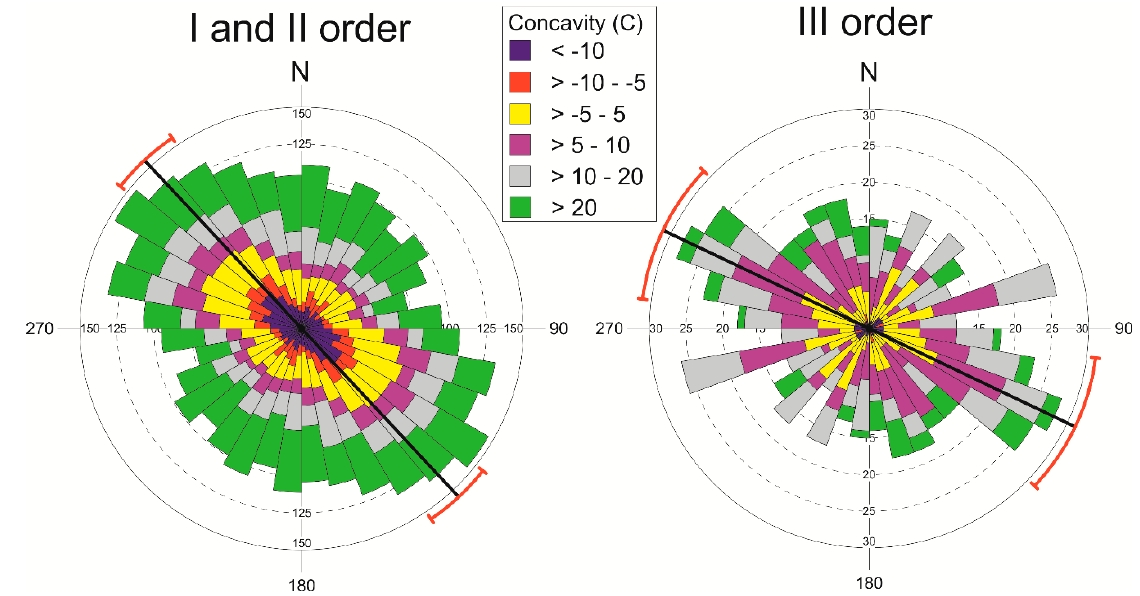
Figure 10. Length-weighted rose diagrams computed for different values of the concavity (C) of river normalized profile.